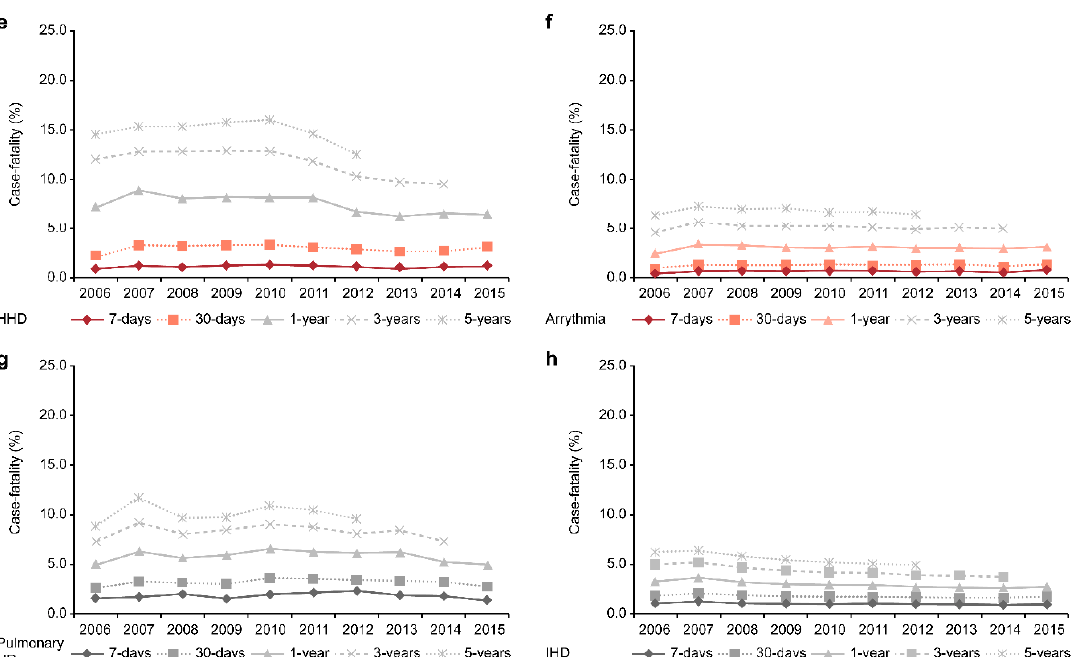
Figure 1. Trend in case fatality rates of HD subtypes in Korea, 2006–2015. ( a ) Overall of heart